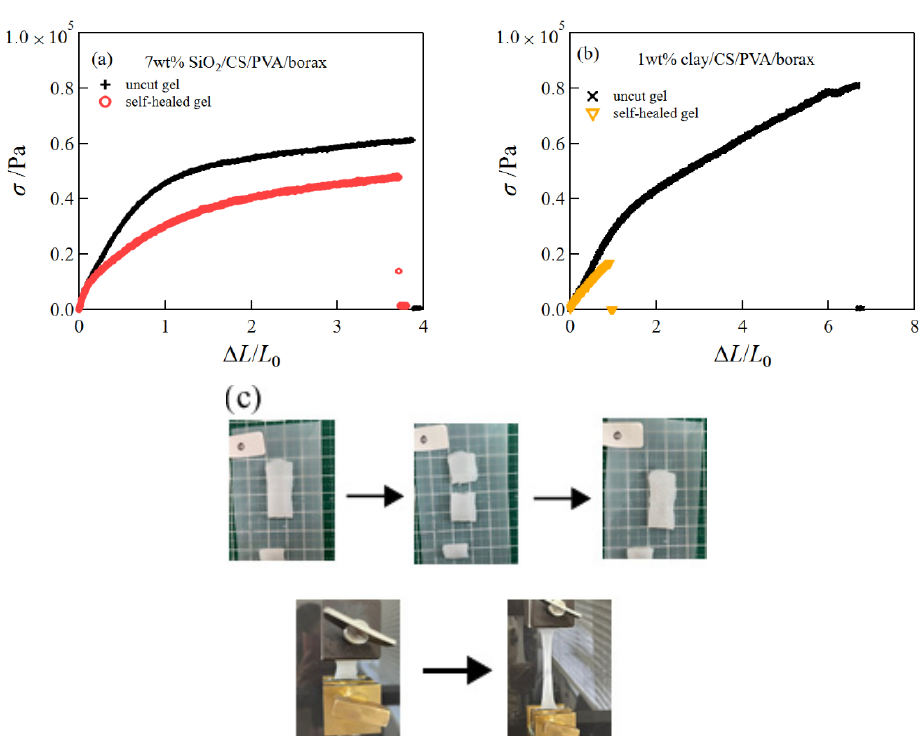
Figure 8. Representative tensile stress–strain curves of the self-healed gel and the uncut gel; 7 wt% SiO 2 /CS/PVA/borax hydrogels ( a ) and 1 wt% clay/CS/PVA/borax hydrogels ( b ). Pictures of a self-healed SiO 2 /CS/PVA/borax hydrogel ( c ).